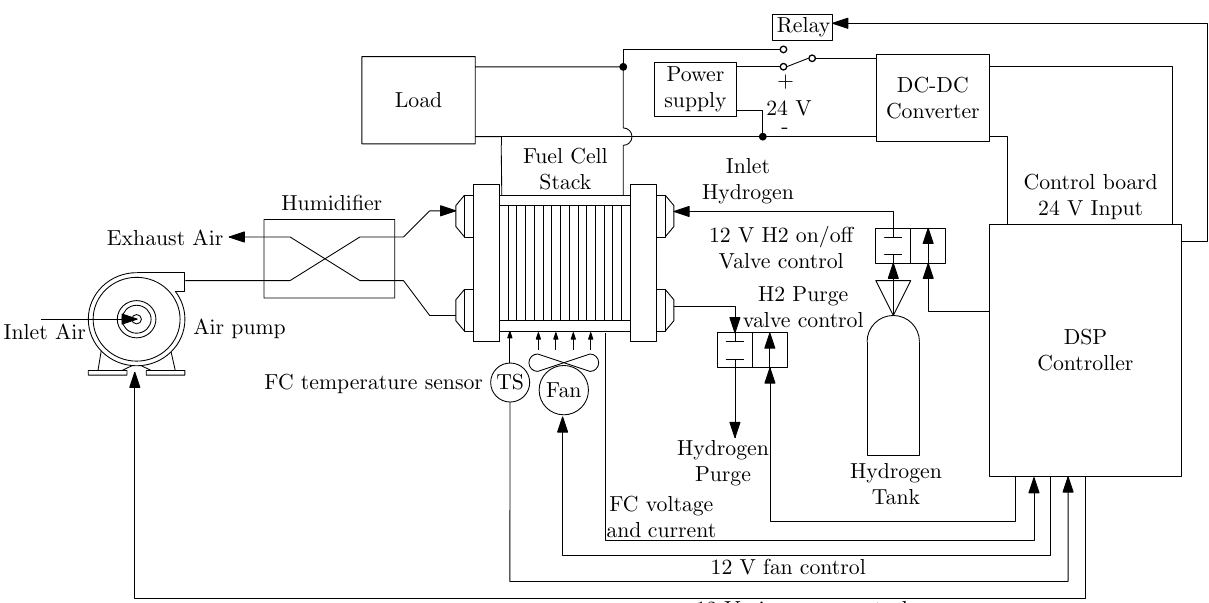
Figure 1. Block diagram of the PC3F40 fuel cell